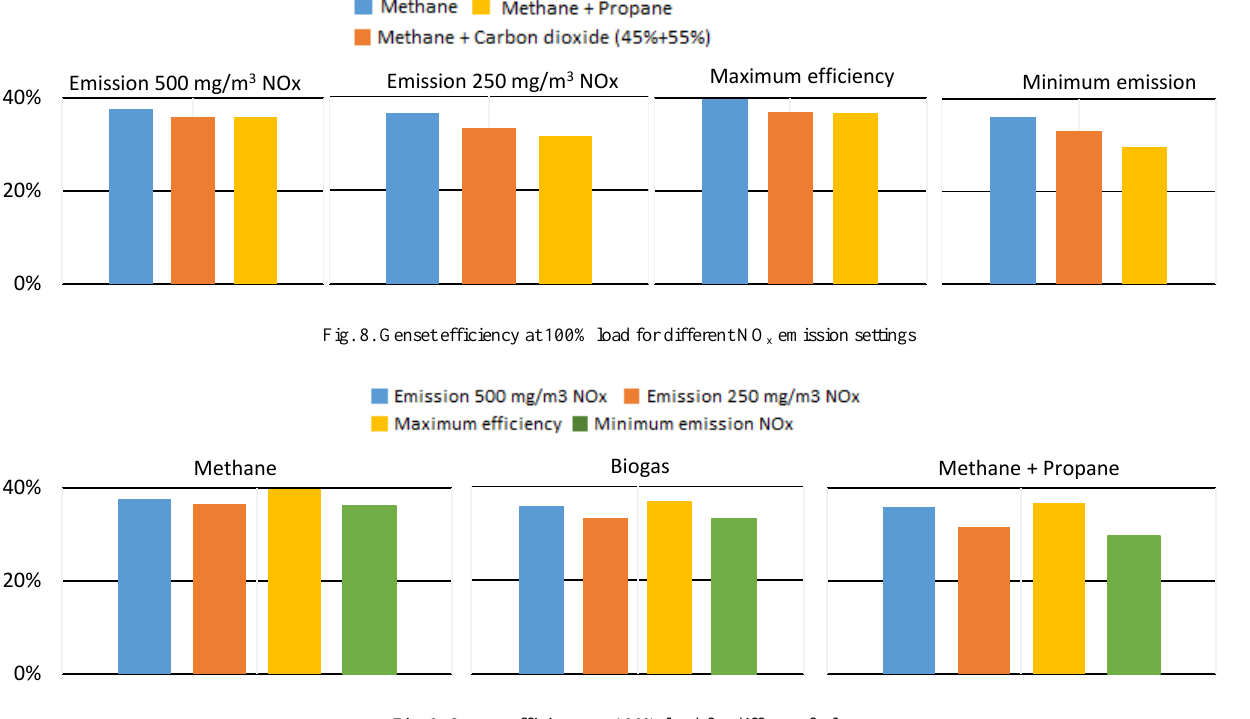
Fig. 9. Genset efficiency at 100% load for different